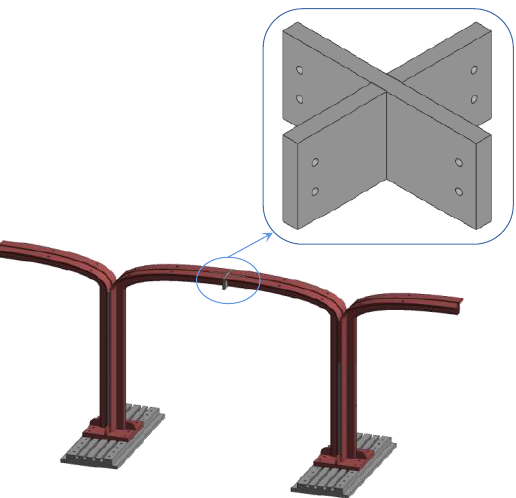
Figure 16. Details of the cross connector between two basic units.